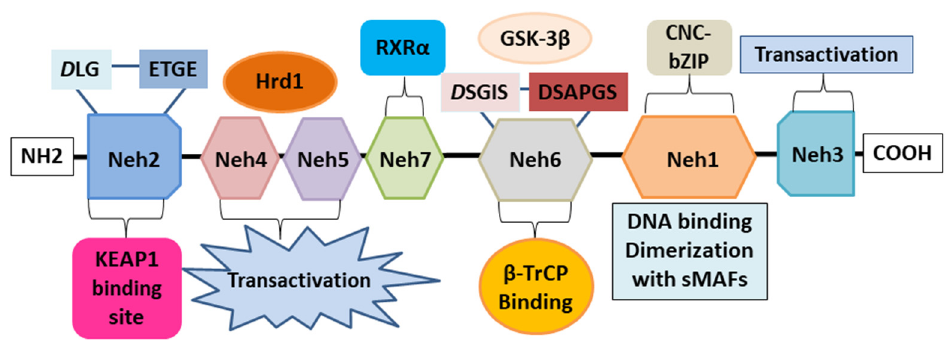
Figure 2. The structural architecture of Nrf2. The structure of Nrf2 contains seven domains, Neh domains, Neh1-Neh7. Neh1 contains a bZip motif, where the basic region is responsible for DNA binding and the zip dimerizes with other binding partners such as sMAFs. Neh2 contains ETGE and DLG motifs, involved in the interaction with Keap1 and subsequent Keap1-mediated proteasomal degradation. Neh3, Neh4, and Neh5 domains are transactivation domains of Nrf2. In particular, Neh4 and five domains interact with the Hrd1 responsible for Nrf2 degradation. The Neh6 domain contains two redox-independent degrons, DSGIS and DSAPGS, that bind to the E3 ubiquitin ligase β -TrCP involved in the Nrf2 degradation in oxidatively stressed cells. The neh7 domain mediates the interaction with RXR α , which represses Nrf2 activity. Nuclear factor erythroid 2-related factor 2: Nrf2; Nrf2-ECH homology: Neh; basic region leucine zipper: bZip; Cap’n’Collar: CNC; small muscleaponeurotic fibrosarcoma: sMAF; Kelch-like erythroid cell-derived protein with CNC homology-associated protein 1: Keap1; β -transducing repeat-containing protein: β -TrCP; retinoic X receptor alpha: RXR α ; Glycogen synthase kinase-3: GSK-3 β ; HMG-CoA reductase degradation 1: Hrd1.